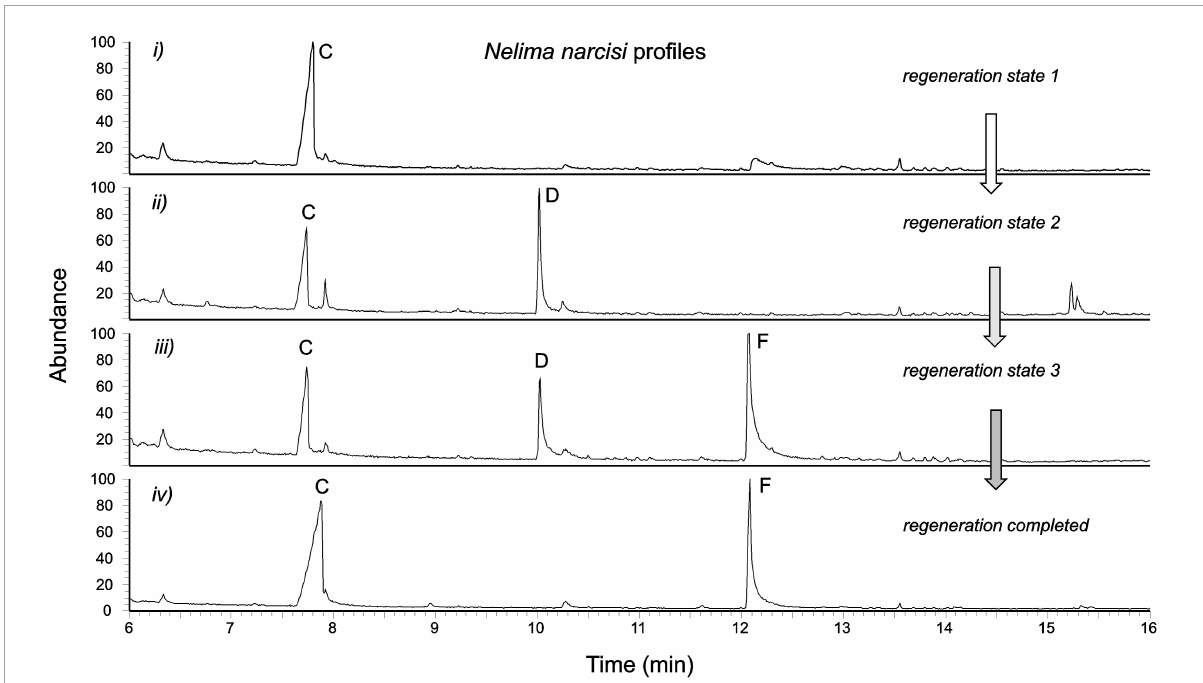
FIGURE8 Different profiles of the secretion of Nelima narcisi adults, possibly indicating different states of secretion biosynthesis/regeneration of secretion after glandular depletion: hypothetically, (2 R ,4 R )-2,4-dimethylhexanoic acid is produced first (i) , followed by the production of 4-phenyl-2-butanone (ii) which is gradually converted/replaced by 2-phenylacetamide (iii,iv) . Compounds: C (2,4-dimethylhexanoic acid); D (4-phenyl-2-butanone); and F (2-phenylacetamide).